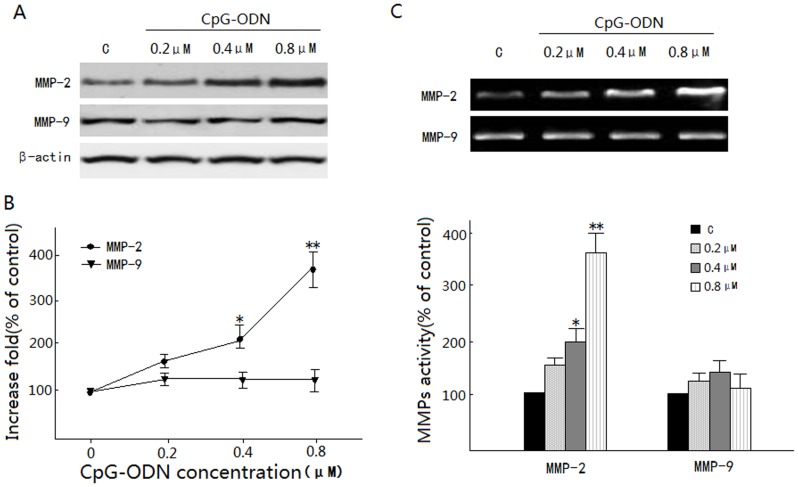
Effects of CpG-ODN on MMP-2 and MMP-9 expressions.(A) Analysis of MMP-2 and -9 protein expression in cells treated with indicated doses of CpG-ODN and harvested at 24 h. β-actin served as an internal control. (B) Determined secretion of MMP-2 and -9 was subsequently quantified by ELISA analysis, and presented as means ± S.D. of three repeats from one independent study. (C) HB cells in serum-free medium were treated with various concentrations (0∼0.8 μM) of CpG-ODN for 24 h. The culture medium of cells after treatment was subjected to gelatin zymography to analyze the activity of MMP-2 and -9; *p<0.05; **p<0.01, compared with the control.